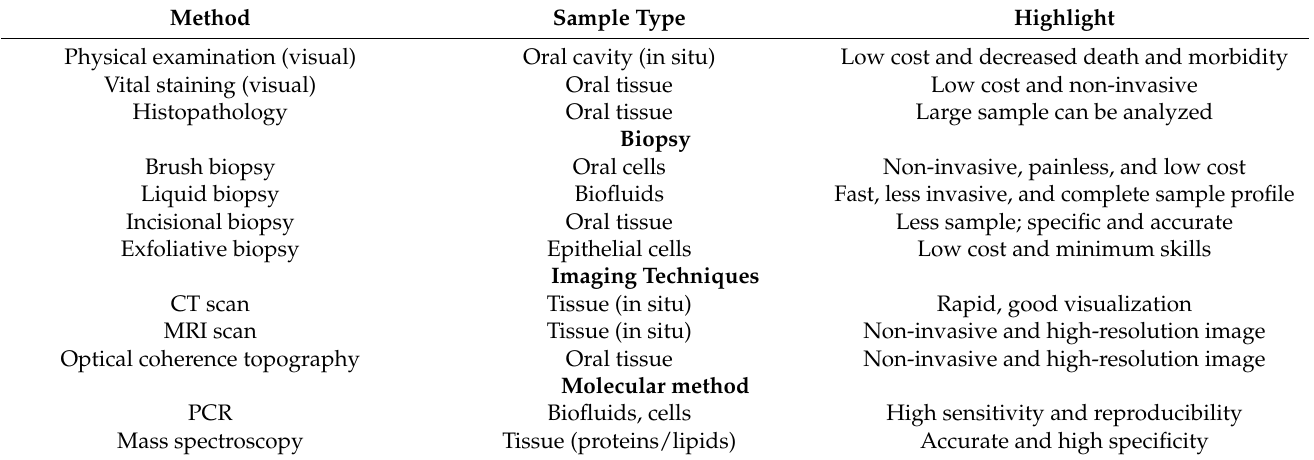
Table 1. Traditional methods for detecting oral